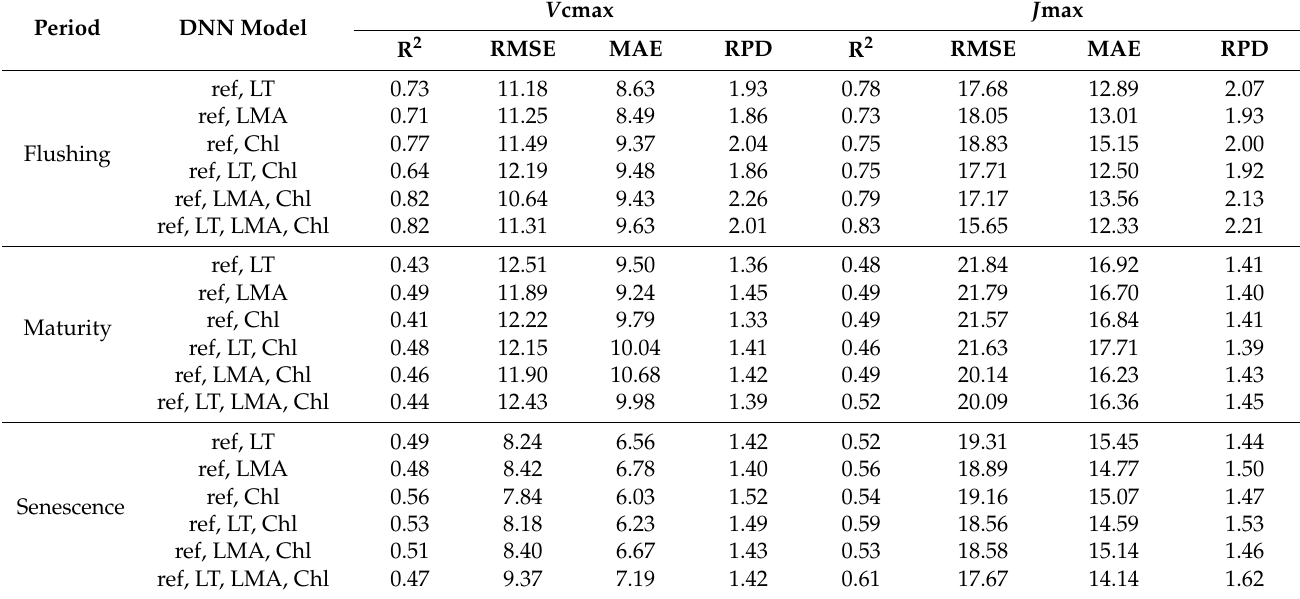
Table 3. Results of DNN model for predicting photosynthetic traits ( V cmax: maximum carboxylation rate; J max: maximum electron transport rate) using hyperspectral information, with different additional leaf traits and their combinations used as predictors during different growing periods (flushing, maturity, and senescence). R 2 : coefficient of determination; RMSE: root mean square error; MAE: mean absolute error; RPD: ratio of performance to standard